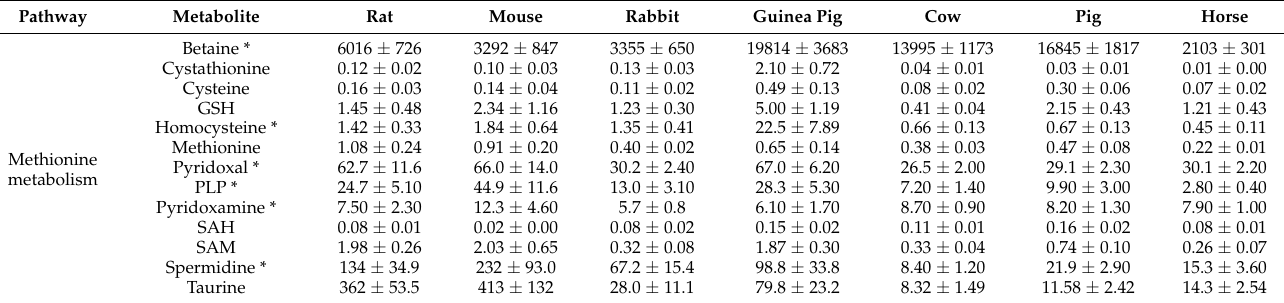
Table A1. Heart metabolite content in mammals. Concentration values are reported in mM per g